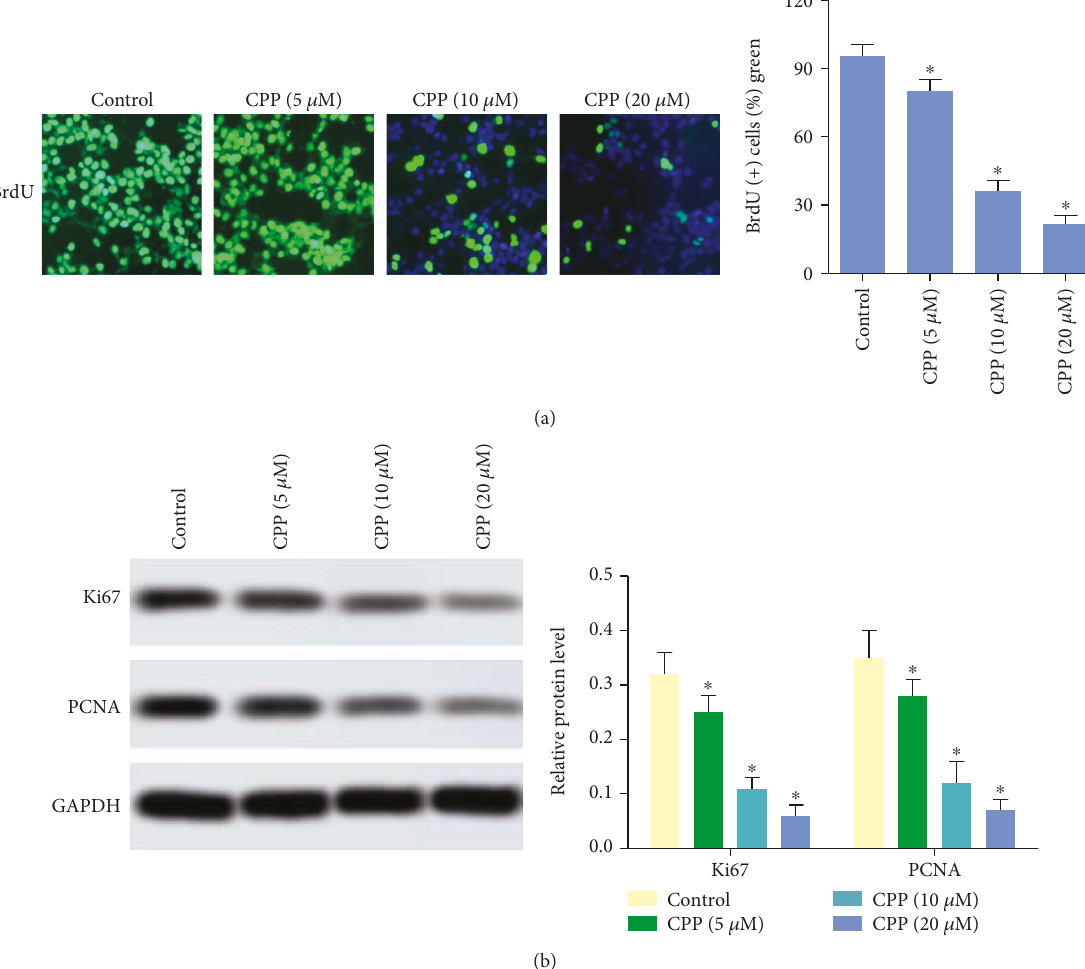
Figure 2: Proliferation of HepG2 cells. (a) Cell proliferation detected by BrdU; (b) protein expression of Ki67 and PCNA was tested by Western blot. ∗ P < 0 05 versus Control group.